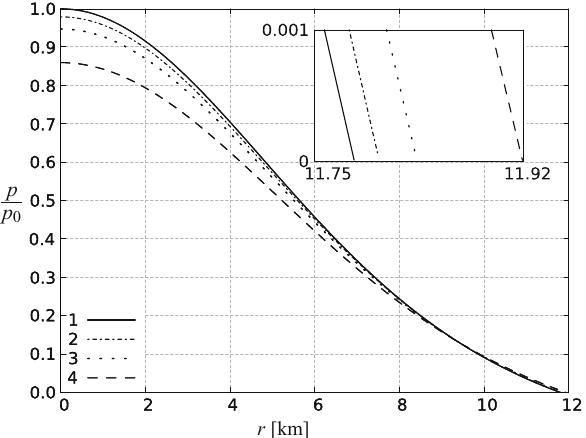
Fig. 6 Pressure profile for compact objects with LQG-inspired cor- rections and MIT-bag EoS B = 50 MeV / fm 3 . The comparison is done for models that have the same classical central density ρ 0 = 1 . 65 × 10 15 g / cm 3 . See Table 3 for details Table 3 Comparison of the radii of the LQG-inspired compact objects with MIT-bag model EoS and central density ρ 0 = 1 . 65 × 10 15 g / cm 3 for different values of the bag constant B in units MeV / fm 3 . Masses